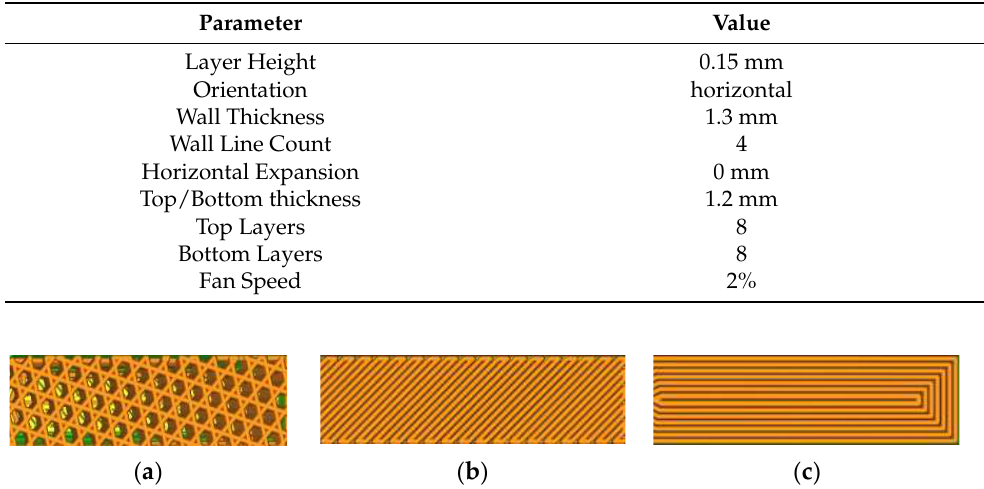
Table 4. Constant variables for printing.